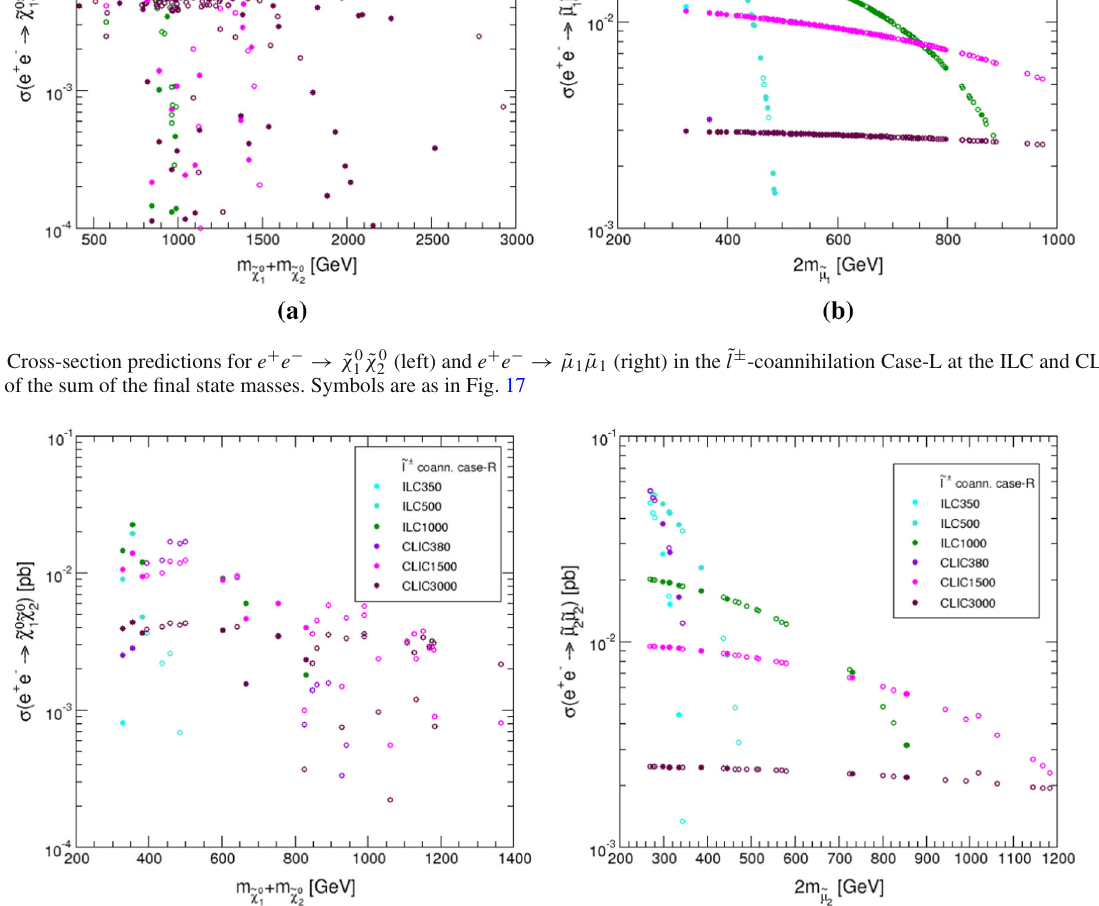
Fig. 19 Cross-section predictions for e + e − → ˜ χ 0 function of the sum of the final state masses. Symbols are as in Fig. 17